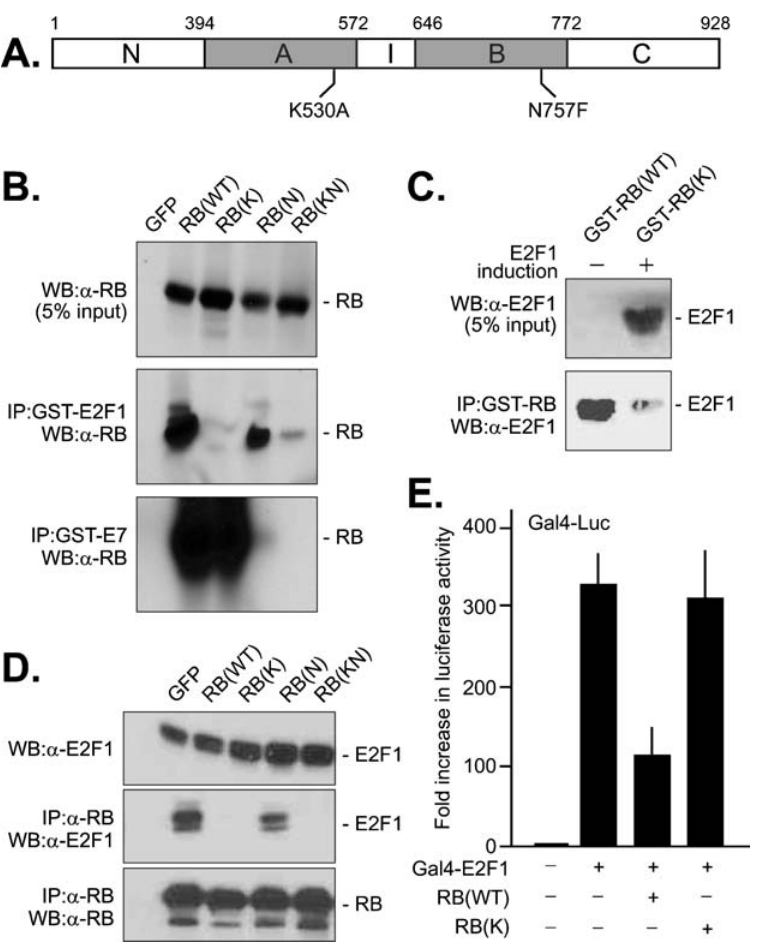
Figure 1. RB K530A mutation disrupts binding to the transactivation domain of E2F. A) Summary of RB mutants. The amino acid numbering is that of the human retinoblastoma protein. Two shaded boxes represent the A and B domains; I, the insert region; N, the region N-terminal to the A domain; C, the region C-terminal to the B domain. B) GST pull-down assay. The RB-deficient MDA-MB468 cells were infected with recombinant adenovirus encoding GFP, RB, RB-K, RB-N or RB-KN, whole cell lysates were incubated with purified GST-E2F1 or GST-E7 fusion protein immobilized on glutathione-Sepharose. The bound fractions were solubilized, fractionated by SDS-PAGE and reacted with an affinity-purified anti-RB. C) Reciprocal GST pull-down assay. Lysates from SAOS-2-tet-E2F1 cells [21] were immunoblotted with anti-E2F1 to demonstrate the induced expression of E2F1 protein (upper panel). Lysates from induced and non-induced cells were incubated with GST-RB or GST-RB-K fusion proteins immobilized on glutathione-Sepharose, and the bound fraction analyzed by immunoblotting with anti-E2F1 (lower panel). D) Co-immunoprecipitation assay. SAOS-2- tet-E2F1 cells [21] were infected with recombinant adenoviruses encoding GFP, RB, RB-K, RB-N or RB-KN and then cultured without tetracycline to induce the expression of E2F1. Co-immunoprecipitation of E2F1 in anti-RB immune complex was determined by immunblotting with anti-E2F1 antibody ( a -E2F1). E) Luciferase assay. The Gal4-Luc reporter plasmid contains a firefly luciferase expression cassette with five Gal4 binding sequence motifs. The Gal4-E2F1 protein contains the Gal4-DNA binding domain and the transactivation domain of E2F1 [22]. SAOS-2 cells were transfected with Gal4-Luc and Gal4-E2F1 plasmids in the presence or absence of RB or RB-K. A plasmid expressing Renilla luciferase from the thymidine kinase promoter was included in the transfections for normalization of transfection efficiency. The firefly and Renilla luciferase activities were measured in each sample, the ratio of which was compared among the different transfections with that from the Gal4-Luc only transfected sample as the baseline. The values shown are averages and standard errors from three independent